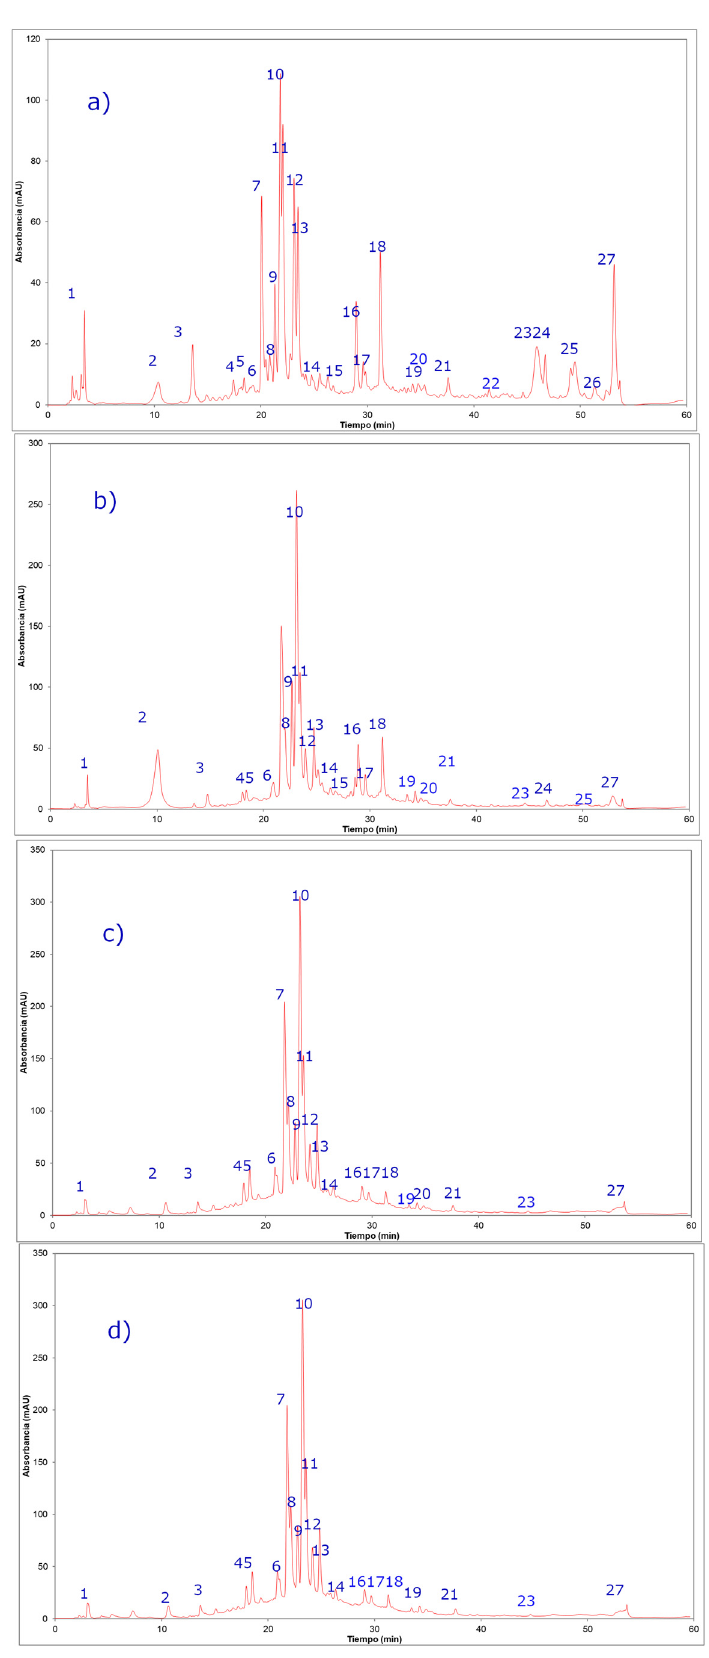
Figure 1. HPLC photodiode assay detector (PDA) chromatograms of Persicaria maculosa extracts (spectra at 280 nm). ( a ) Curicó ethanolic extract, ( b ) Valparaíso ethanolic extract, ( c ) Curicó methanolic extract, ( d ) Valparaíso methanolic extract.